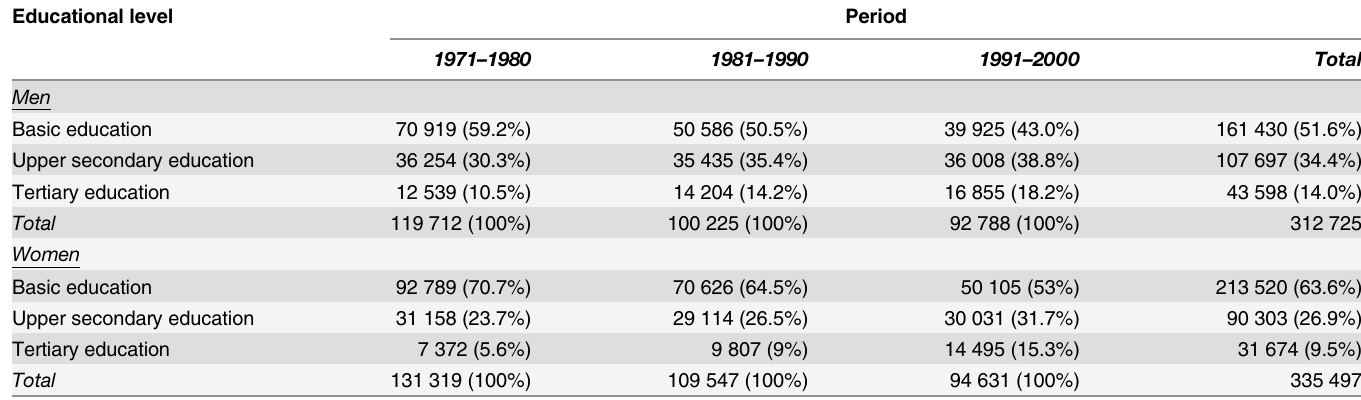
Table 1. Number (%) of the study population with basic, upper secondary and tertiary education at age 60 (at the time of study inclusion) by gender and time